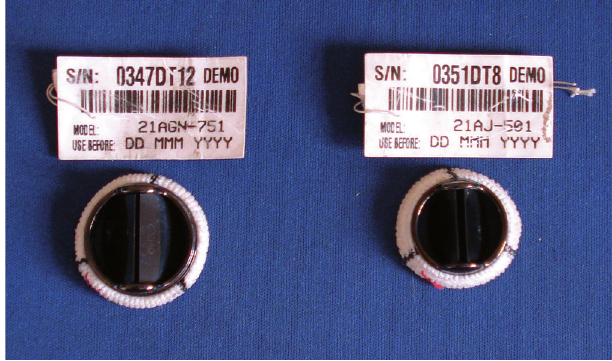
Fig. 3 - Aortic bi-leaflet prosthetic heart valves used Highlighted: from left to right, models 21 AGN - 751 and 21 AJ - 501